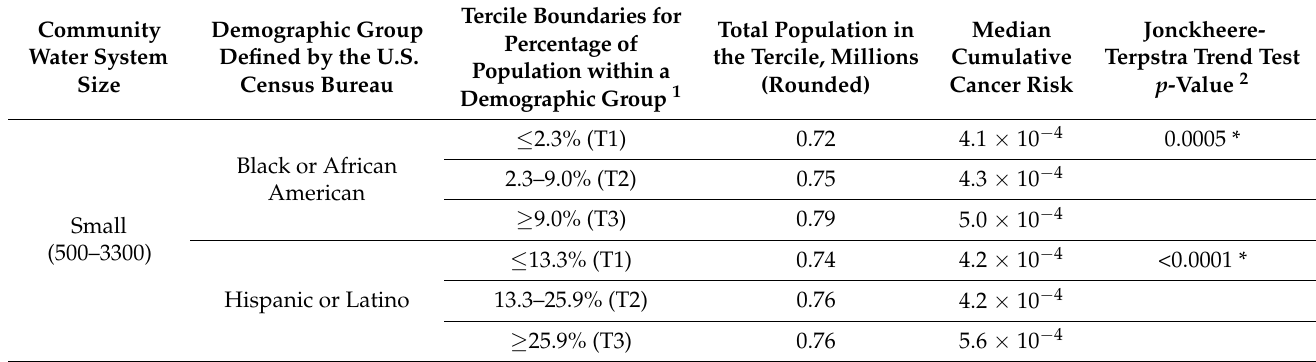
Table 3. Cumulative cancer risk for community water systems in Texas grouped by system